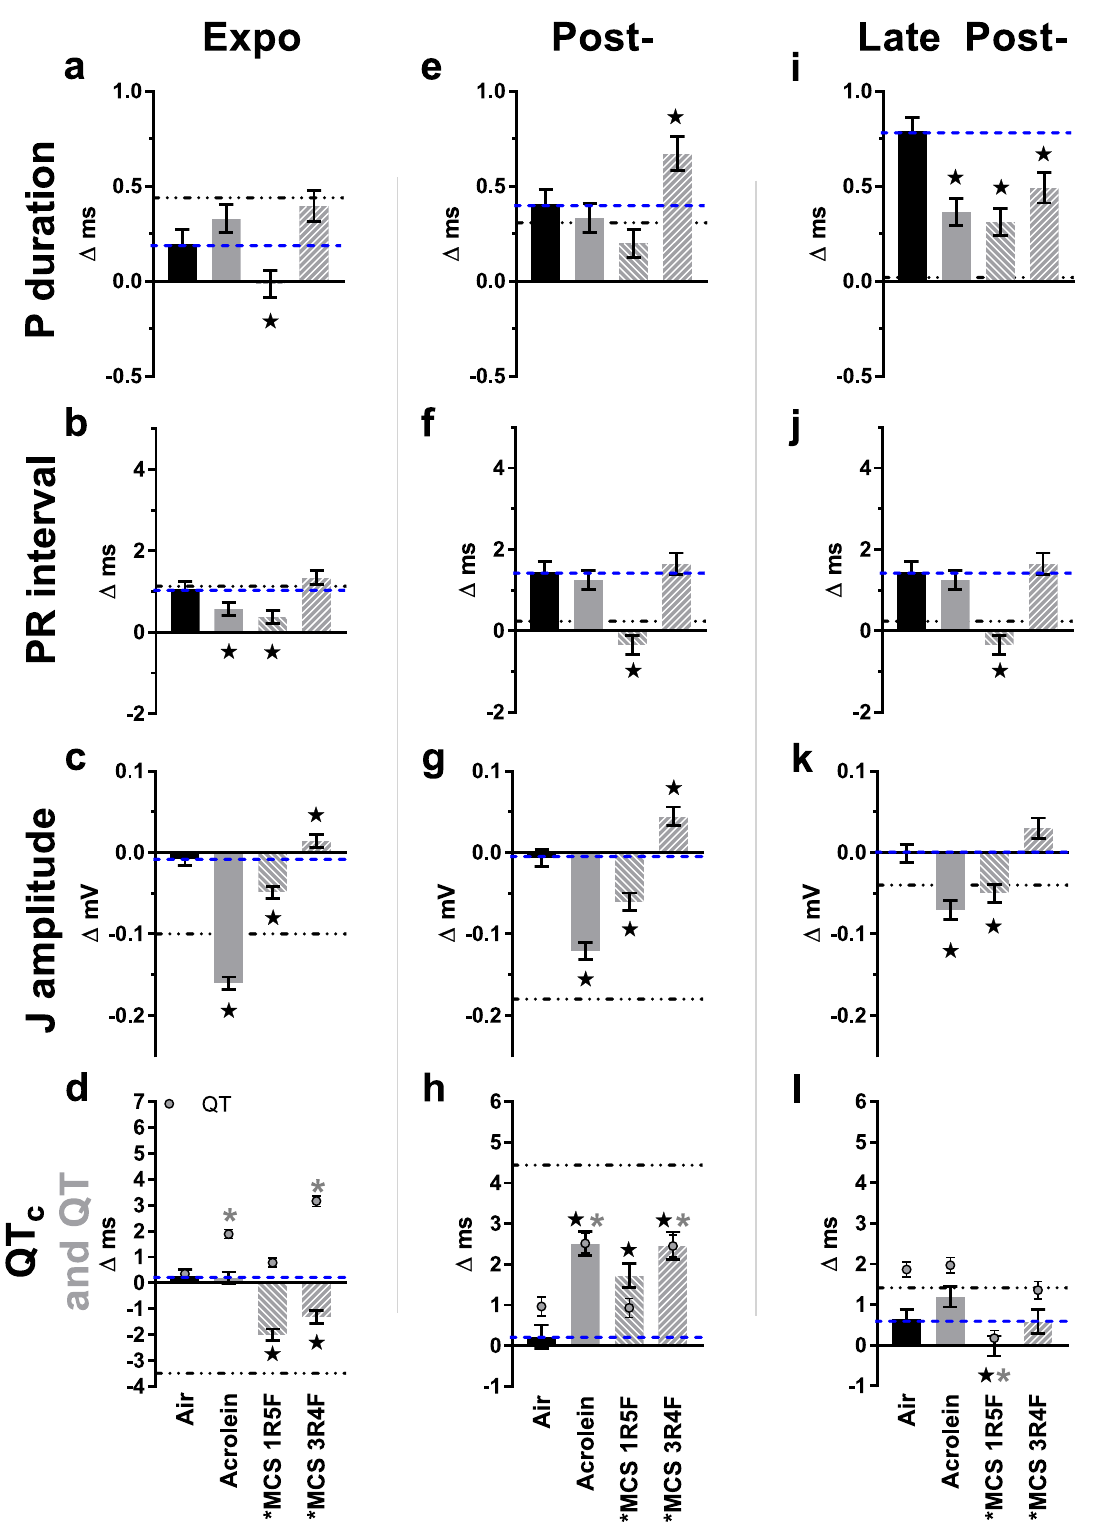
Fig. 8 | Inhalation exposure to cigarette smoke or acrolein alters supraven- tricular conduction and ventricular repolarization. Bars represent least square means(±SEM)ofchangefrom5-minbaselineinPduration,PRinterval,Jamplitude, QT c interval,anduncorrectedQT(graycircles)accordingtoexposurephases( a – l ). Blue dashes mark Air mean ( n =8) and dot-dashes mark VG mean as reference.